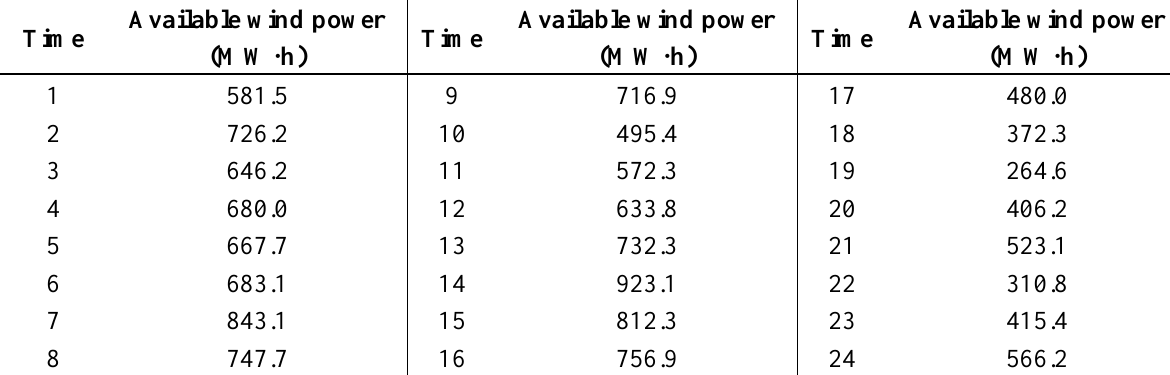
Table 2. 24 h output power of wind farm.